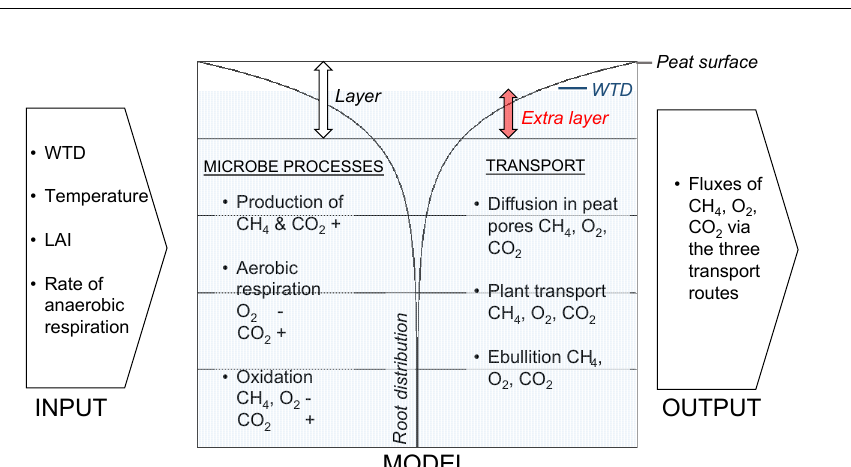
Figure 1. HIMMELI as a simplified schematic picture. The microbial and transport processes are simulated in a vertically layered one- dimensional peat column in which roots of aerenchymatous gas-transporting plants are distributed according to the exponential root distribu- tion function. The input anoxic respiration is distributed along the root distribution. Input water table depth (WTD) determines the thickness of the possible extra layer that is introduced in the event the WTD does not match any of the fixed background layer borders. This ensures that all the simulated layers are either completely water filled or air filled. The + sign shows that the compound is produced in the microbial process and the − sign means consumption of the